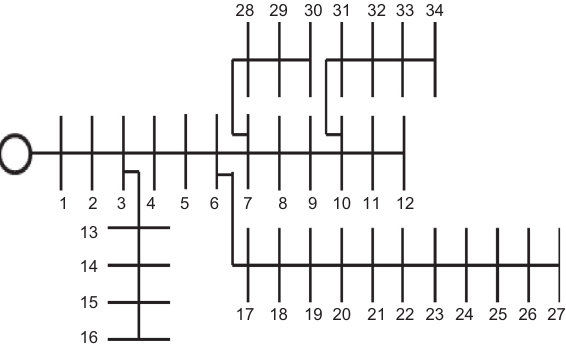
Figure 4 IEEE-34 bus radial distribution test system. Figure 2. General interconnection among nodes in the IEEE 34-node test feeder.